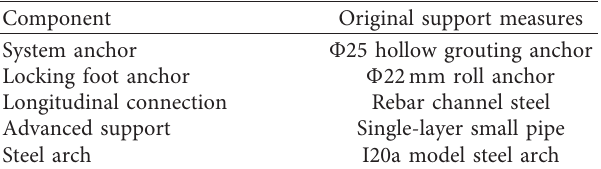
Figure 1: The geographical location of the Qiguding tunnel. Table 1: Original support